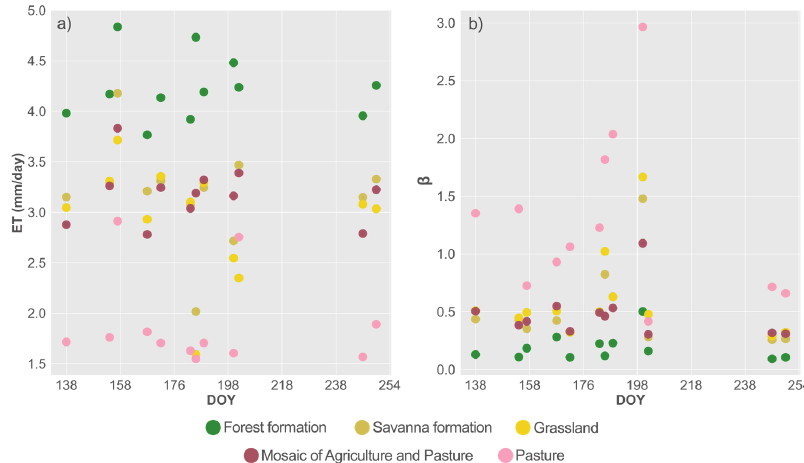
Figure 6. Spatial patterns of land cover ( a ) and the dry season average of vegetation index ( (cid:1840)(cid:1830)(cid:1848)(cid:1835) ) ( b ), surface temperature ( (cid:1846) (cid:3046) ) ( c ), and daily evapotranspiration ( (cid:1831)(cid:1846) ) ( d ) in the study area for the year 2004 DOY 200.